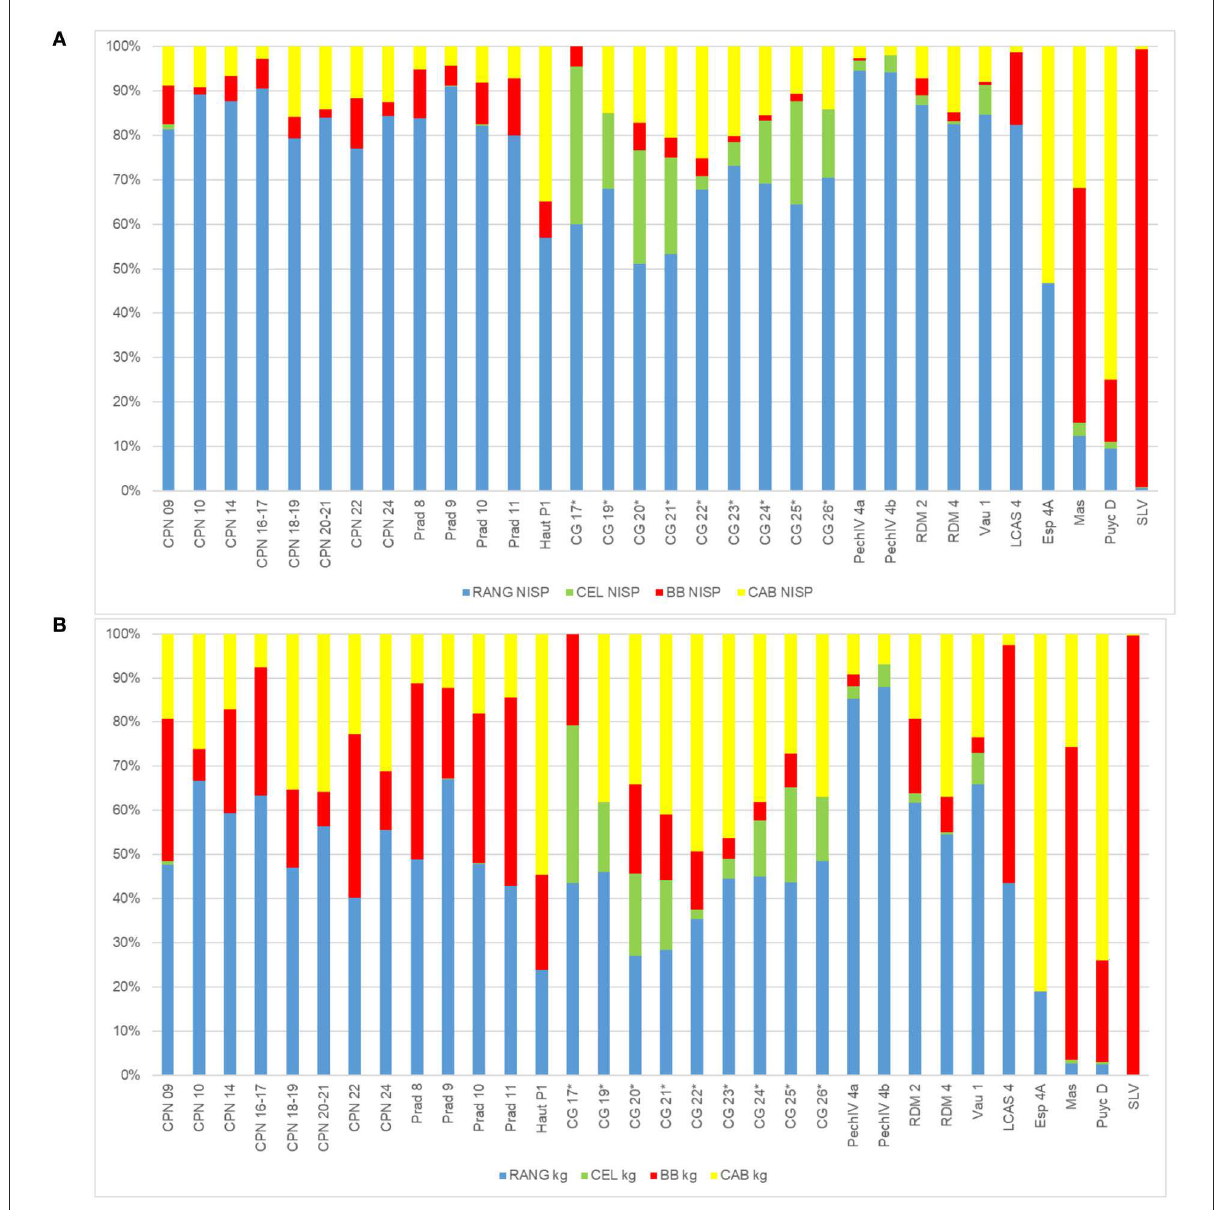
FIGURE9 Spectra (A) in %NISP, (B) in kg of meat; Blue, reindeer; green, red deer; Red, bison; Yellow, horse; Gray, other). References used for data CG, Combe Grenal (Laquay, 1981; Guadelli, 1987); Vau, Vauffrey (Delpech, 1996); PechIV, Pech de l’Azé IV (Laquay, 1981; Niven, 2013); RdM, Roc de Marsal (Castel et al., 2017); LP, Les Pradelles (Costamagno et al., 2006); CPN, Chez-Pinaud-Jonzac (Airvaux, 2004; Jaubert et al., 2008b; Niven, 2013); LCAS, La Chapelle-aux-Saints (Rendu et al., 2014); Haut, Hauteroche (Paletta, 2005); LR, La Rouquette (Rendu et al., 2011); SLV, Sous les Vignes (Turq et al., 1999); ESP, Espagnac (Jaubert, 2001). Numbers correspond to the different stratigraphic units. *For Combe Grenal Reindeer was under-evaluated in the previous excavation due to selective